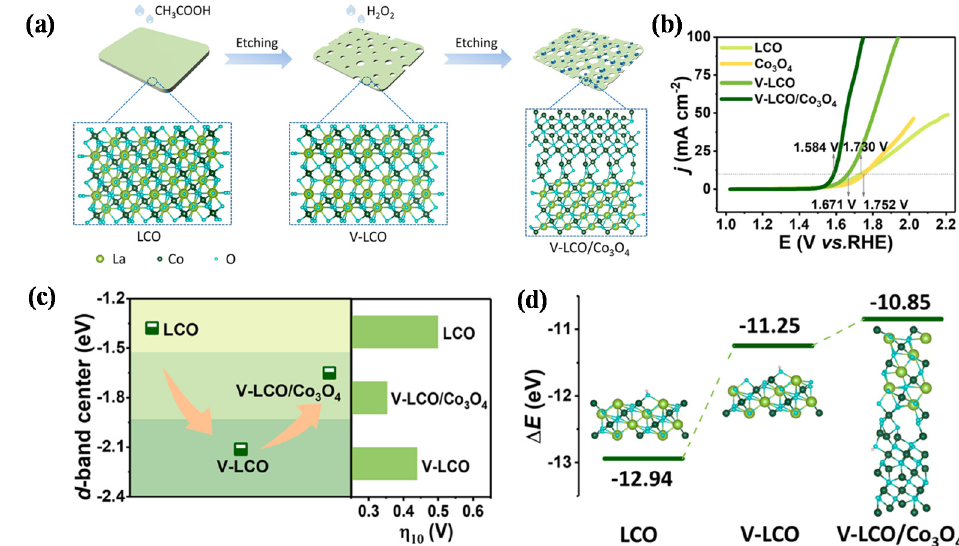
Figure 7. ( a ) Preparation process for the V-LCO/Co 3 O 4 heterostructure. ( b ) Polarization curves of LCO, V-LCO, V-LCO/Co 3 O 4 , and pure Co 3 O 4 for OER in 1.0 M KOH. ( c ) A comparison of the over- potential and the Co d -band centers of LCO, V-LCO, and V-LCO/Co 3 O 4 . ( d ) The surface adsorption energy difference ( Δ E ) for the OH of pristine LCO, V-LCO, and V-LCO/Co 3 O 4 . Reproduced with permission from ref. [19], Copyright 2021, American Chemical Society.